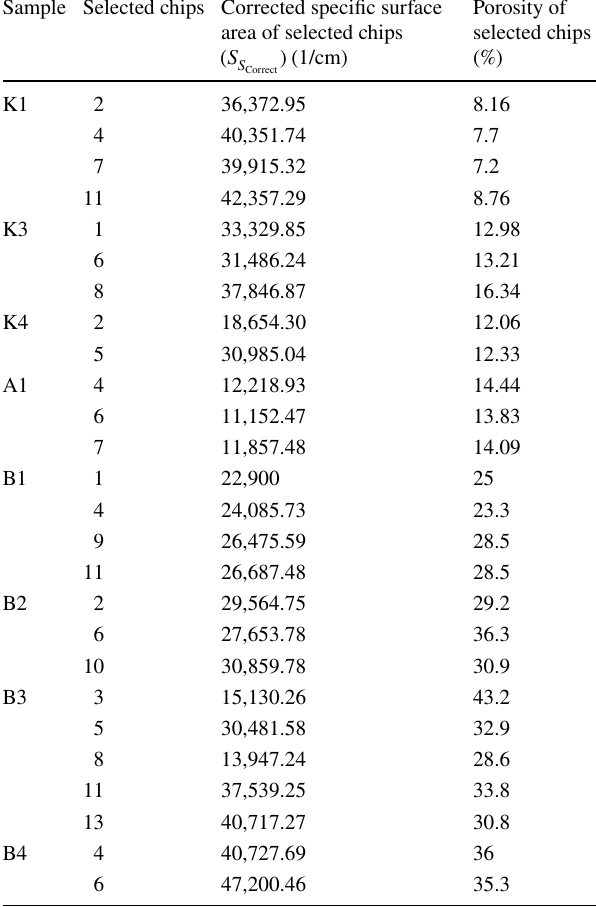
Table 11 Correlation coefficient, R 2 , maximum error, mean squared error and mean absolute error of